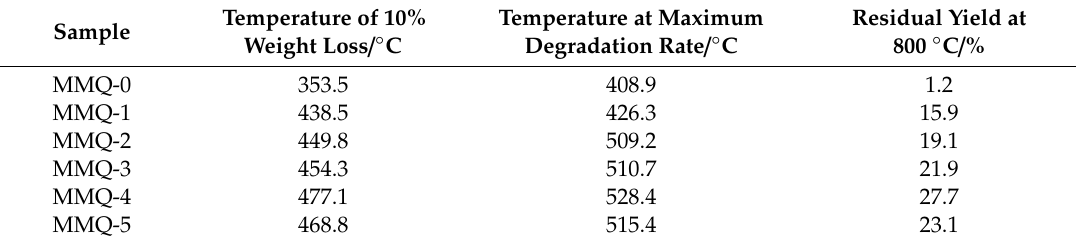
Table 2. The important characteristic data of TG curing for RTV silicone rubbers obtained in a N 2